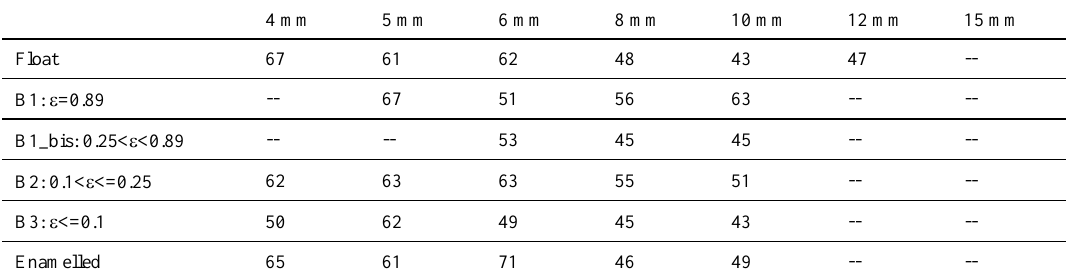
Table 8. Maximum value SC (MPa) vs conform FR for HS in SSV tested specimens